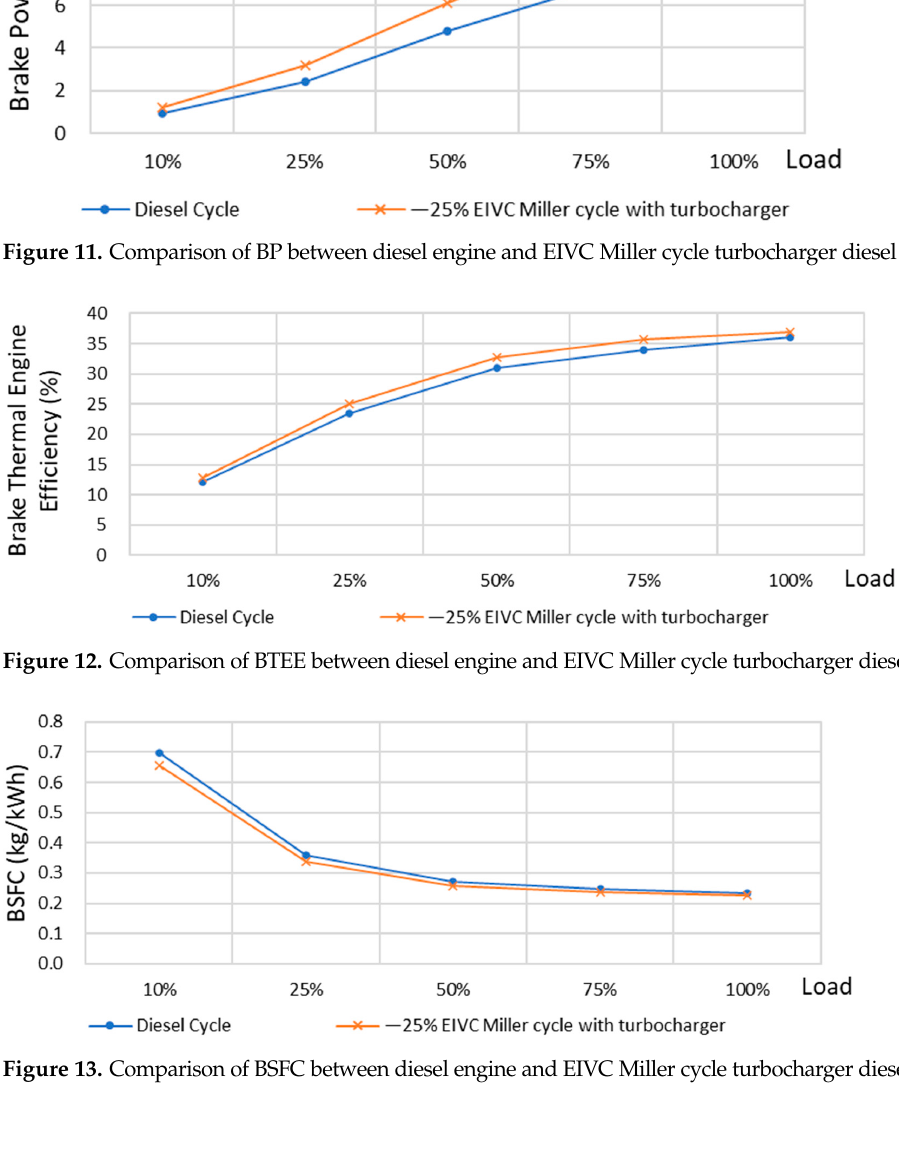
Figure 14. Comparison of NOx between diesel engine and EIVC Miller cycle turbocharger diesel engine. 3.3. Performance and Emission of Diesel Cycle Engines Using Ethanol As can be seen from the Figure 11, brake power is decreased to different degrees in engines using ethanol as fuel compared to diesel, which is normal because the calorific value of ethanol is lower than that of diesel, approximately two thirds of diesel [42]. What is noteworthy, however, is the increase in brake power of approximately 11% for 50% load and 0.5% for 25% load, which can be explained by the fact that ethanol contains 34.8% oxygen, which allows for the full combustion of the incomplete part of the diesel fuel, thus increasing the power [43]. In addition, ethanol causes a significant growth in BSFC, with a maximum increment of 81%, occurring at 10% load. This is a result of the high latent